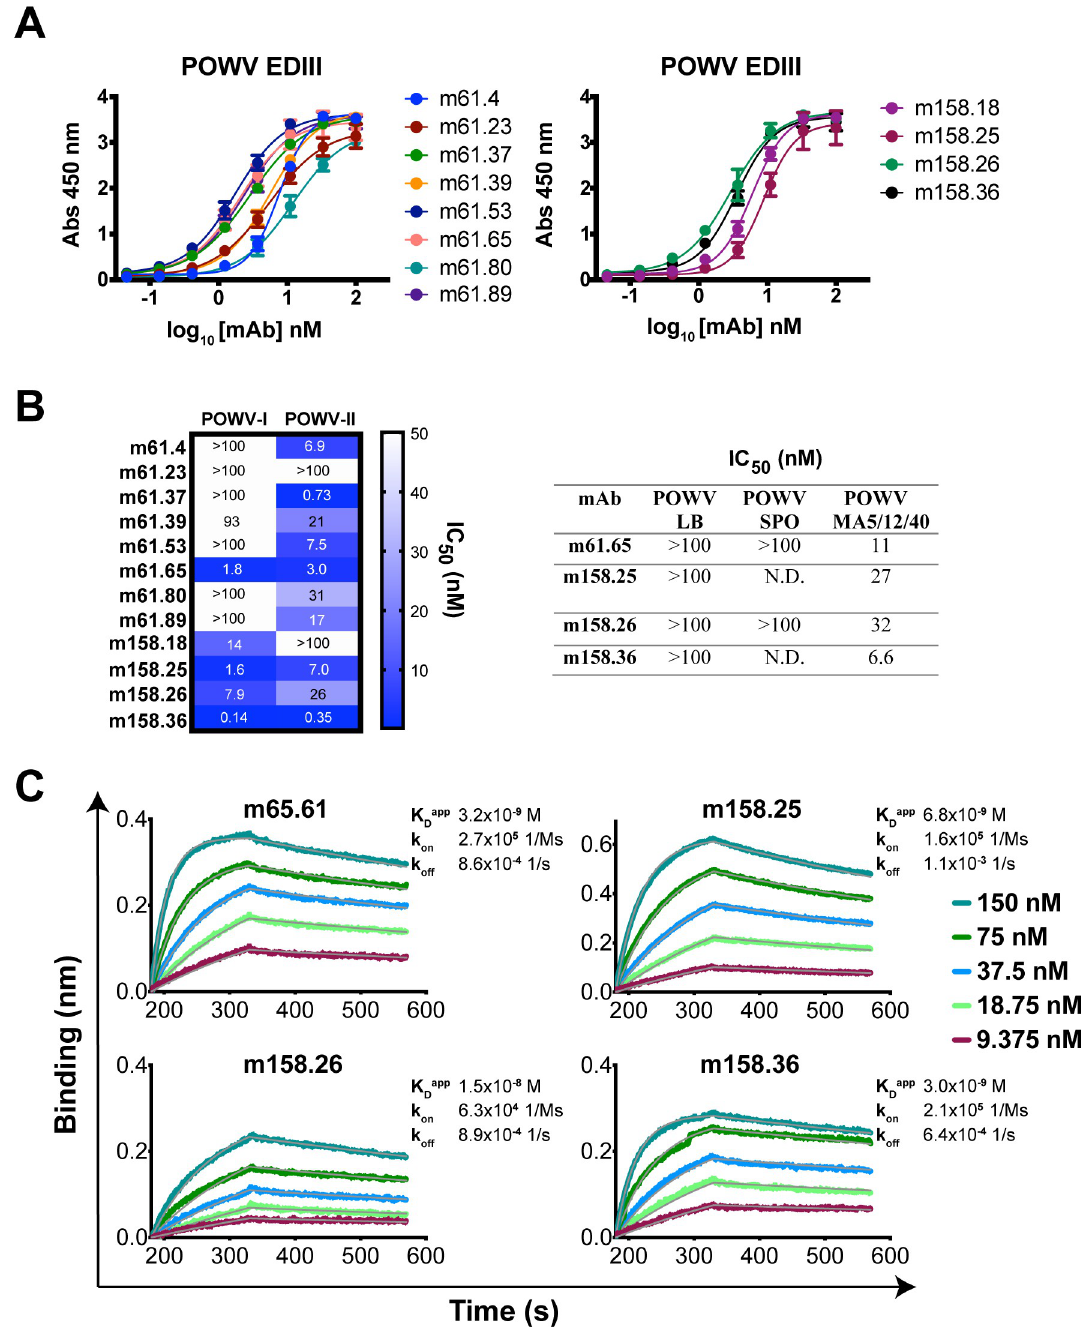
Fig 5. Binding and neutralization profiles of POWV EDIII mAbs. ( A ) ELISA reactivity of mAbs isolated from LS-POWV-EDIII immunized mice m61 (left) and m158 (right). Full curve ELISAs were performed twice independently in triplicate wells (mean ± SD). ( B ) Neutralization profiles of EDIII-reactive mAbs. A heatmap of IC 50 values for 12 mAbs against POWV RVPs (left) and a table of IC 50 values for the four most potent mAbs against authentic POWV strains (right) are shown. Neutralization curves were performed twice independently in triplicate wells (mean ± SD). ( C ) Binding of neutralizing mAbs to recombinant MBP-POWV by BLI. A representative dataset from two independent experiments is